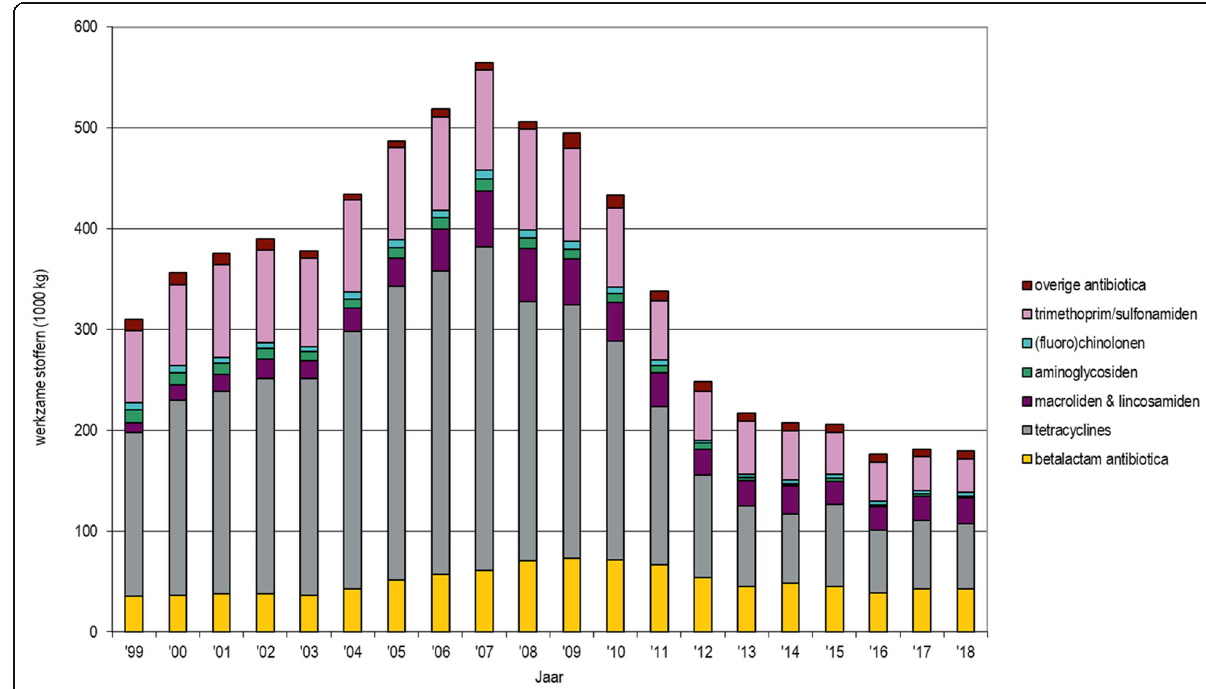
Fig. 10 Total sales of antimicrobials for use in animals in the Netherlands (source: